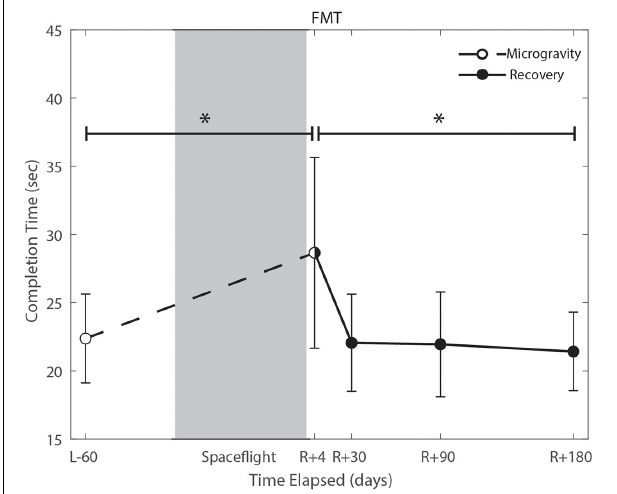
FIGURE 2 | Functional mobility test (FMT) performance changes from pre- to post-flight and post-flight recovery. Spaceflight resulted in a significant decrease in completion time ( p = 0.001). Completion time recovered to baseline levels by approximately 30 days post-flight ( p = 0.0001). *Indicates statistical results that are p <